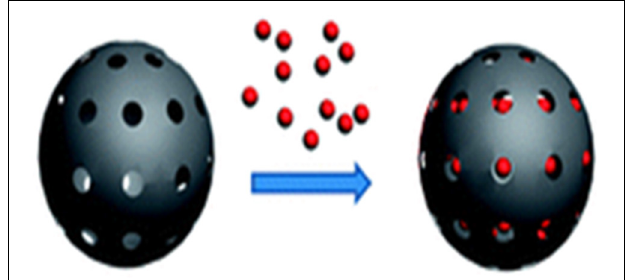
FIGURE 2 | Mesoporous silica nanoparticles